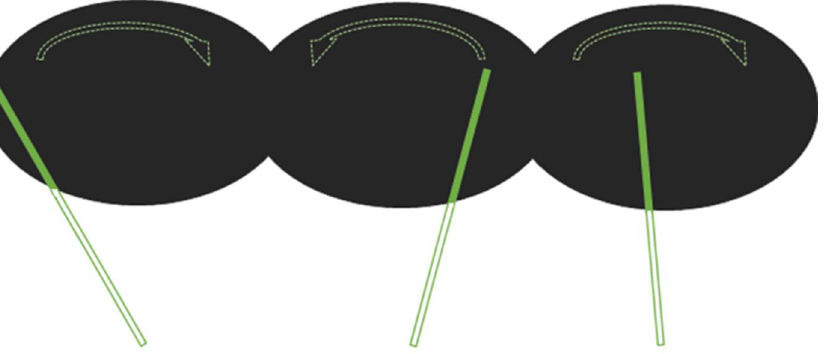
Figure 1. Schematic diagram of the subjective straight-ahead (SSA) fMRI task. Dotted arrows repre- sent the direction of motion.